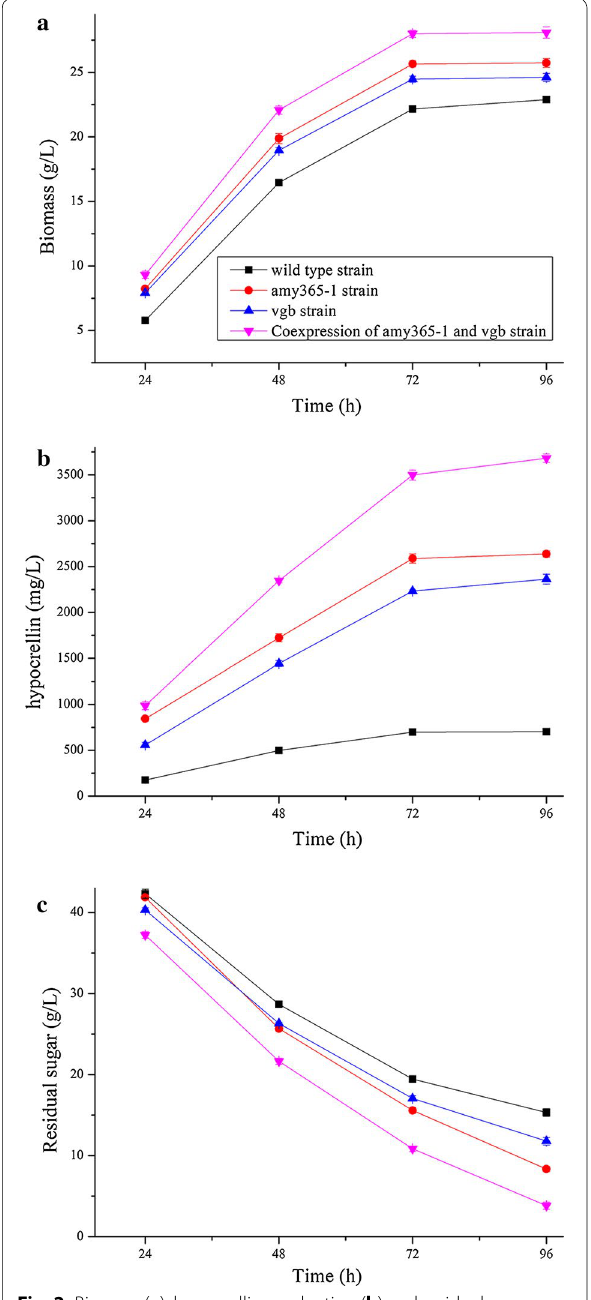
Fig. 2 Biomass ( a ), hypocrellin production ( b ) and residual sugar ( c ) cultured under liquid state fermentation by three overexpression transformants and wild type strain. The error bars represent standard deviation of triplicate measurements. Standard deviations were under 14 per cent of the averages